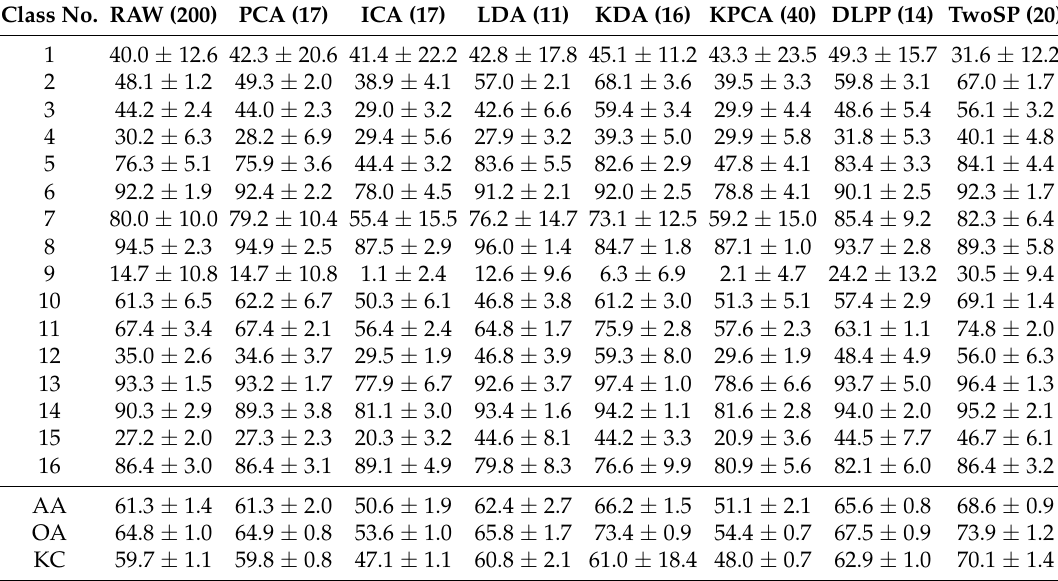
Table 2. Performance (%) of different methods (with the best reduced dimensionality in brackets) on the Indian Pines dataset using the NN